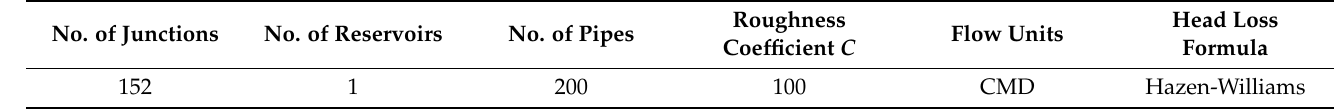
Table 2. Main characteristics of the Cheongna WDN model.